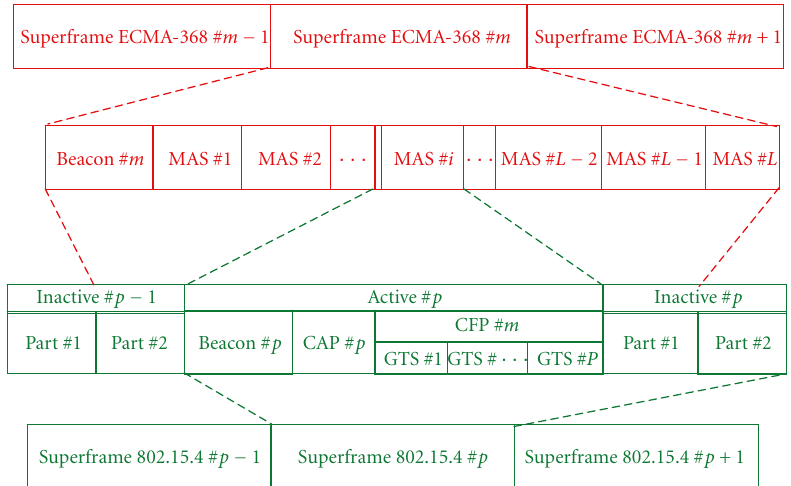
Figure 9: Interaction of the superframe structures for the AWA coexistence mechanism.